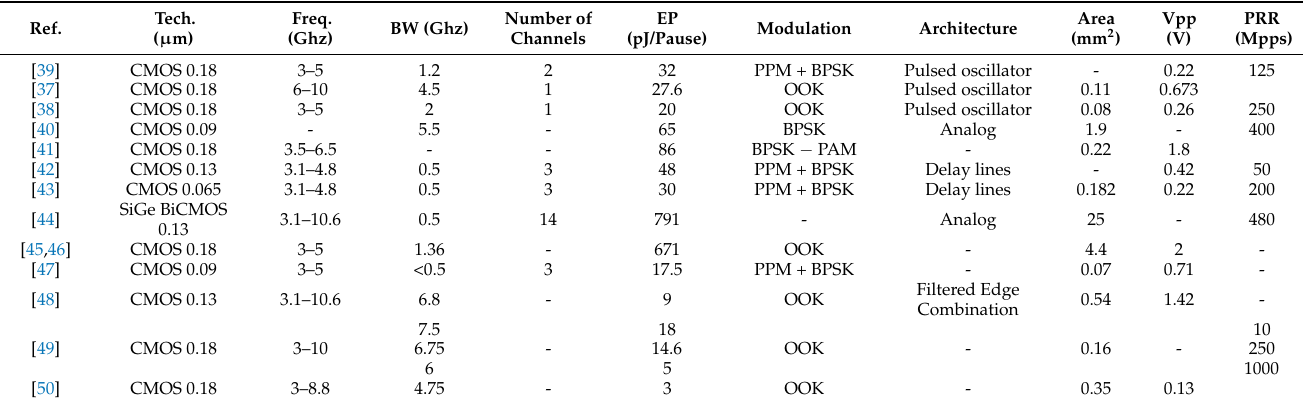
Table 2. Summary of UWB pulse generators in different